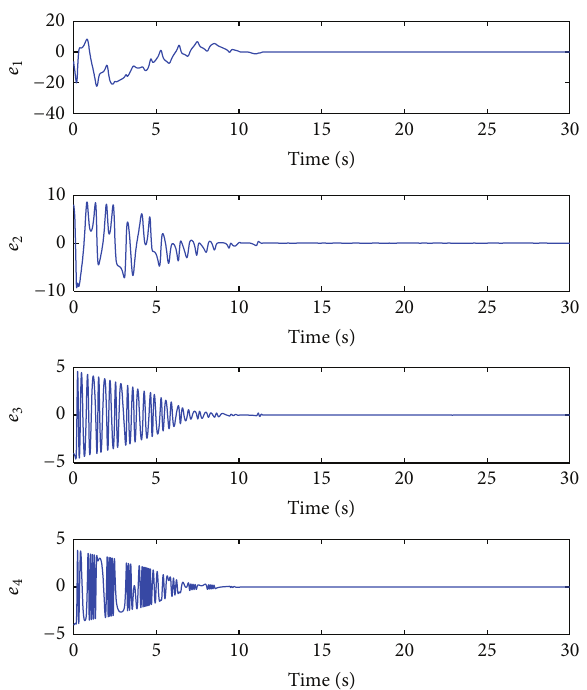
Figure 7: The states of the error dynamical system